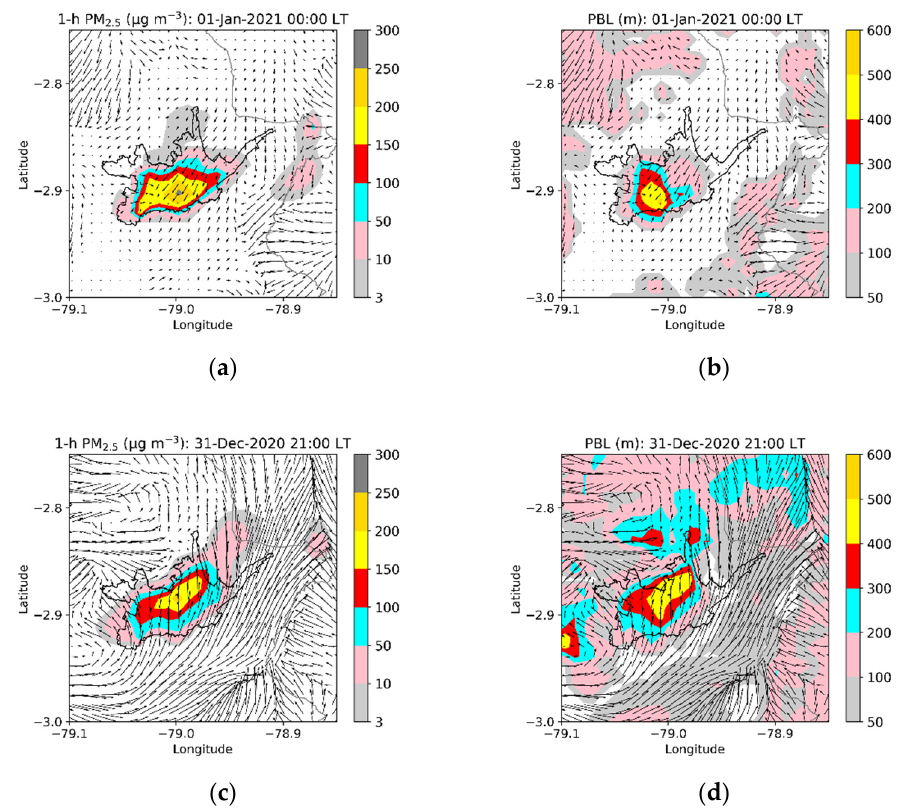
( d ) Figure 8. Modeled maps of PM 2.5 and planetary boundary layer (PBL) depth. Reference scenario: New Year’s emissions starting on 1 January 2021 at 00:00 LT ( a , b ). Scenario with New Year’s emissions starting on 31 December 2020 at 21:00 LT ( c , d ). Table 3. Effect of advancing the time of burning puppets and fireworks. Scenario 1 January at 00:00 LT vs. 31 December at 21:00